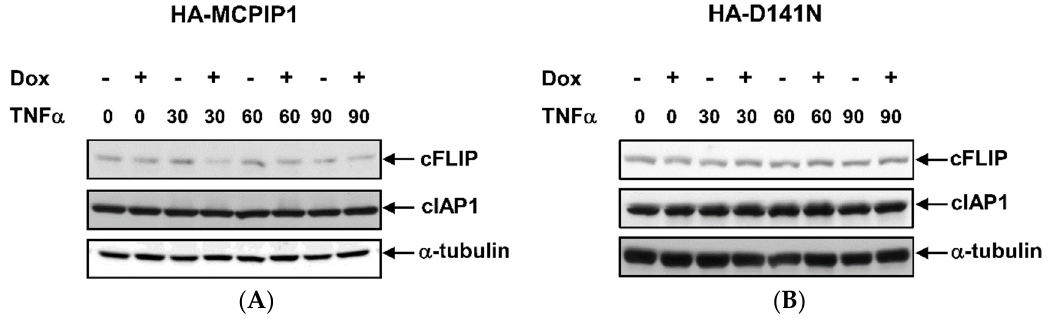
Figure 6. Overexpression of MCPIP1 inhibited cFLIP expression in TNF- α -treated cells. T-REx-293 cells with ( A ) wild-type hemagglutinin (HA)-MCPIP1 or ( B ) the HA-MCPIP1-D141N mutant (HA-D141N) were pretreated without or with 1 µ g/mL of doxycycline (Dox) for 16 h, and then treated without or with 10 ng/mL TNF- α for 30~90 min. Total cell lysates were collected, and protein expressions were determined by Western blotting.